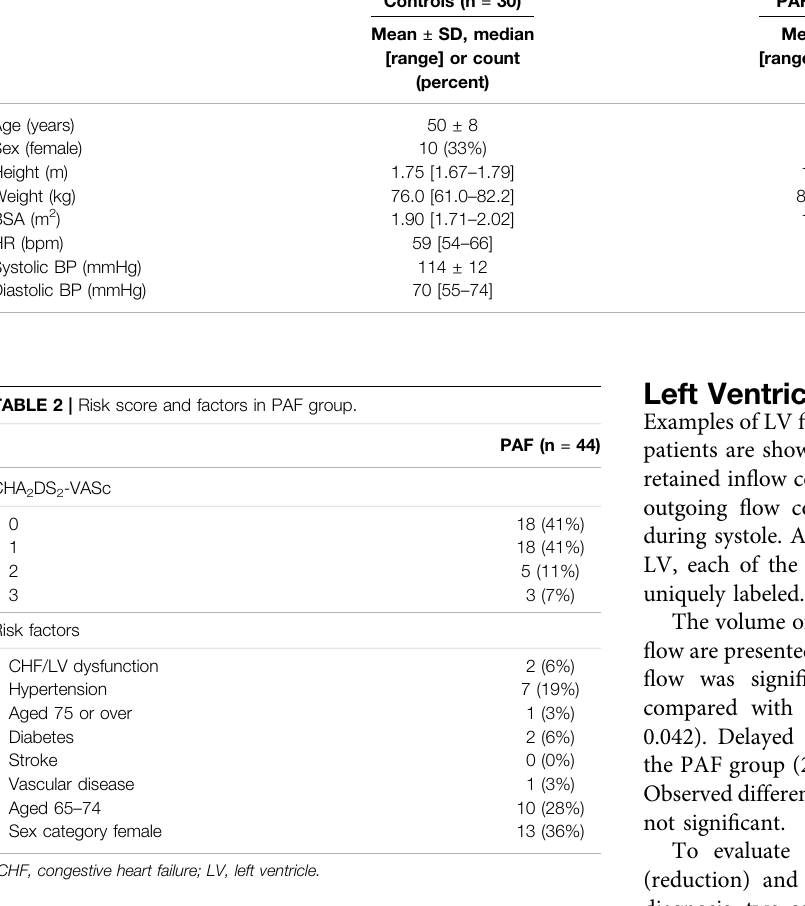
the PAF cohort versus controls (56 ± 12 years vs. 50 ± 8 years, p (cid:1) 0.009). Also, weight and BSA tended to be higher in the PAF